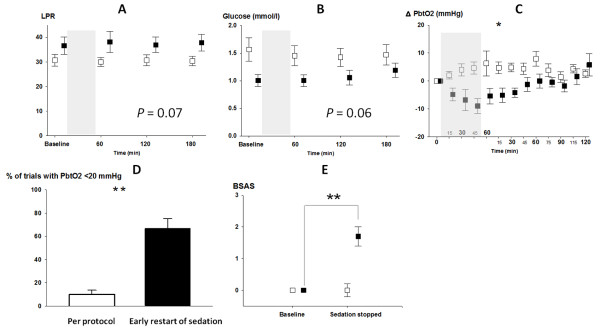
Changes in brain metabolism, brain tissue oxygen tension and bsas during is-trials. Average time course of MD parameters before and after the IS-trial (Panel A-B). Panel C shows average time course of PbtO2 at baseline (time = 0) during the trial (grey-square) and over two hours following restart of sedation and analgesics (x-axis). Panel D gives the percentage of trials with PbtO2 < 20 mmHg in both groups. In Panel E the bedside shivering scale of both groups is shown. Groups are reflected as patients who completed the trial (empty square) and patients who developed a failure criteria (filled square). Error bars represent means and one standard error of n = 54 individual trials. P-value is given for significant differences (** = P < 0.001, * = P < 0.05). BSAS, bedside shivering assessment scale; LPR, lactate-pyruvate ratio; PbtO2, brain tissue oxygen tension.